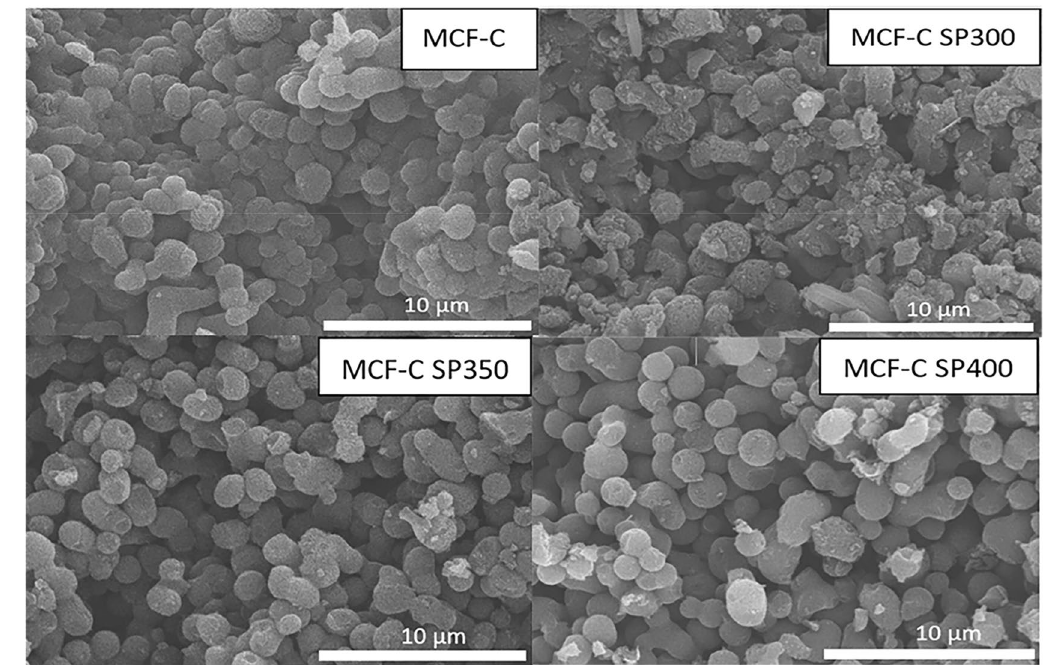
Figure 3. Low magnification SEM image of MCF-C, MCF-C SP300, MCF-C SP350, MCF-C